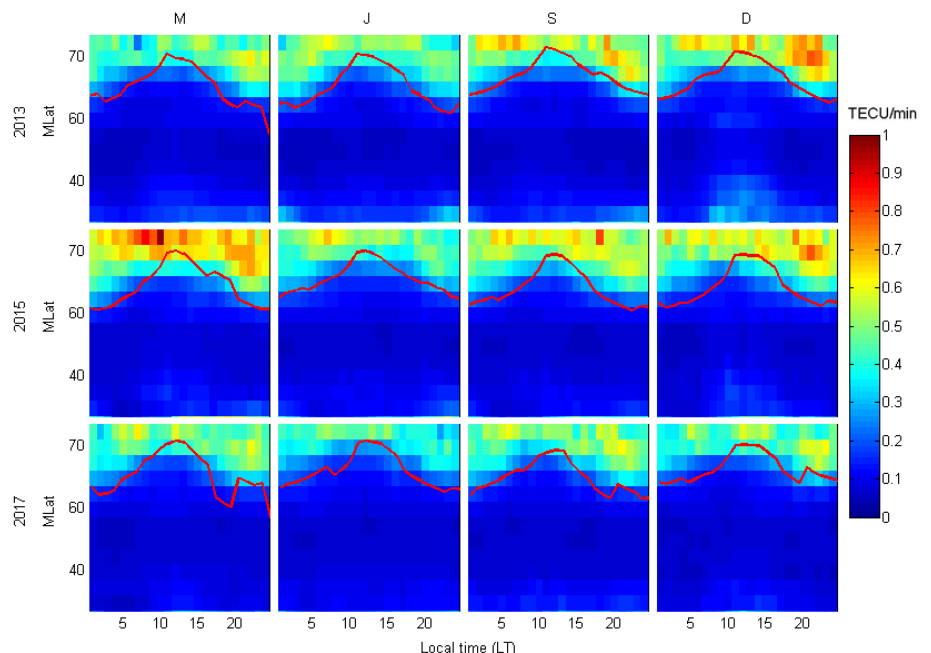
Figure 10. ROTI seasonal (March, June, September, and December-centered seasons) averages of the ROTI values in 2013, 2015, and 2017 (in subsequent rows respectively) as a function of magnetic latitude (MLat) and time (TT, hours). European sector. The red line shows the equatorward boundary of the auroral oval provided by the IRI-2016 model.